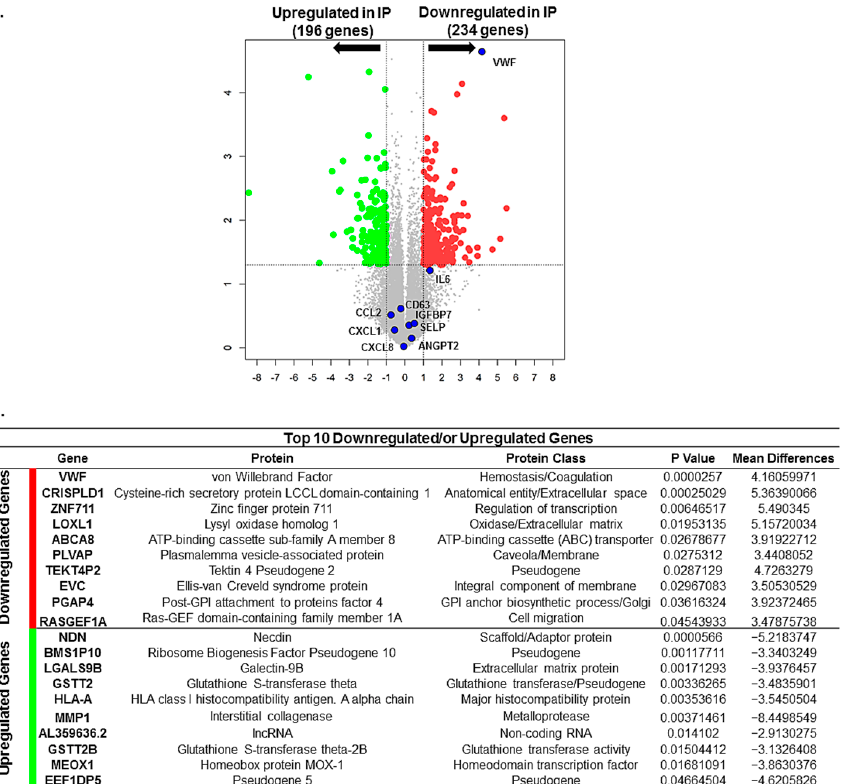
Figure 5. Differentially expressed genes (DEGs) and the top 10 downregulated or upregulated genes in index patient (IP) endothelial colony-forming cells (ECFCs) . ( a ) Volcano plot demon- strates significantly DEGs in IP ECFCs in which –log10 ( p ) is plotted against the mean differences. Green dots represent the upregulated genes and red dots represent downregulated genes. Numbers of genes upregulated or downregulated are indicated. Dashed lines represent the threshold of statistical significance. DEGs were considered significant when p -value < 0.05 and fold change was greater than 2 with respect to healthy ECFC samples or absolute log2FC (log2 fold change or called mean difference) was more than 1. A negative mean difference value points to lower expression in healthy controls (upregulated expression in IP), and a positive mean difference indicates lower expression in IP-ECFCs. The blue dots illustrate the expression of the VWF, the main Weibel–Palade body (WPB) cargo, which is significantly downregulated, as well as expression of inflammatory cargos of WPBs (Ang2, CCL2, CD63, IGFBP7, CXCL8, IL6, CXCL1, and SELP), which does not show any changes compared with healthy ECFCs. Ang2 (ANGP2), angiopoietin-2; CCL2 (known as MCP-1), C-C motif chemokine ligand 2; IGFBP7, insulin-like growth factor binding protein 7; CXCL8 (known as interleukin 8 (IL8)), C-X-C motif chemokine ligand 8; IL6, interleukin 6; CXCL1 (knows as GROa), C-X-C motif chemokine ligand 1; SELP, P-selectin. ( b ) The table presents the top ten downregulated as well as top ten upregulated genes in the ECFCs isolated from the patient. The list is generated according to the mean difference (absolute log2FC), and they are sorted by decreasing p -value in the present